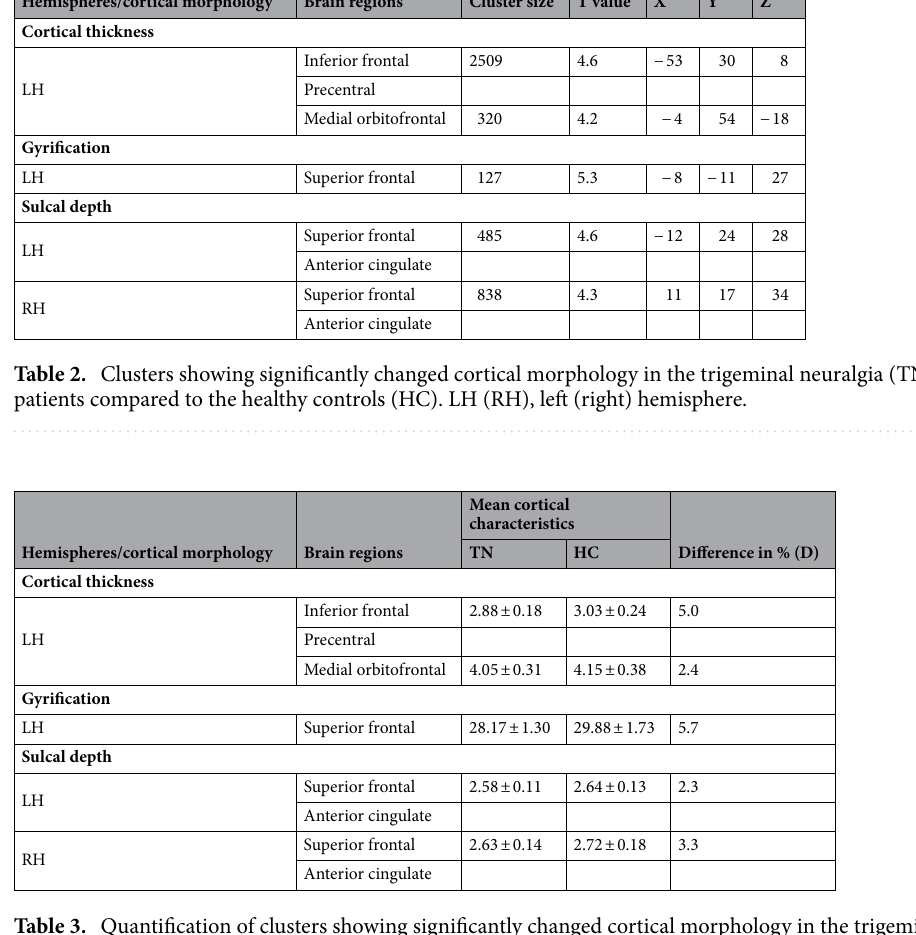
Table 3. Quantification of clusters showing significantly changed cortical morphology in the trigeminal neuralgia (TN) patients compared to the healthy controls (HC). LH (RH), left (right) hemisphere. Difference in % (D) was calculated using the equation: D = (TN −